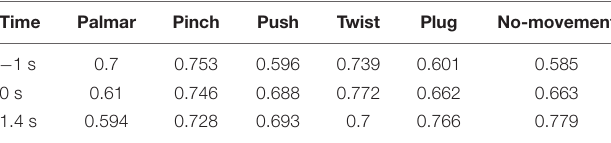
TABLE 4 | The modularity of network for each condition of S2.